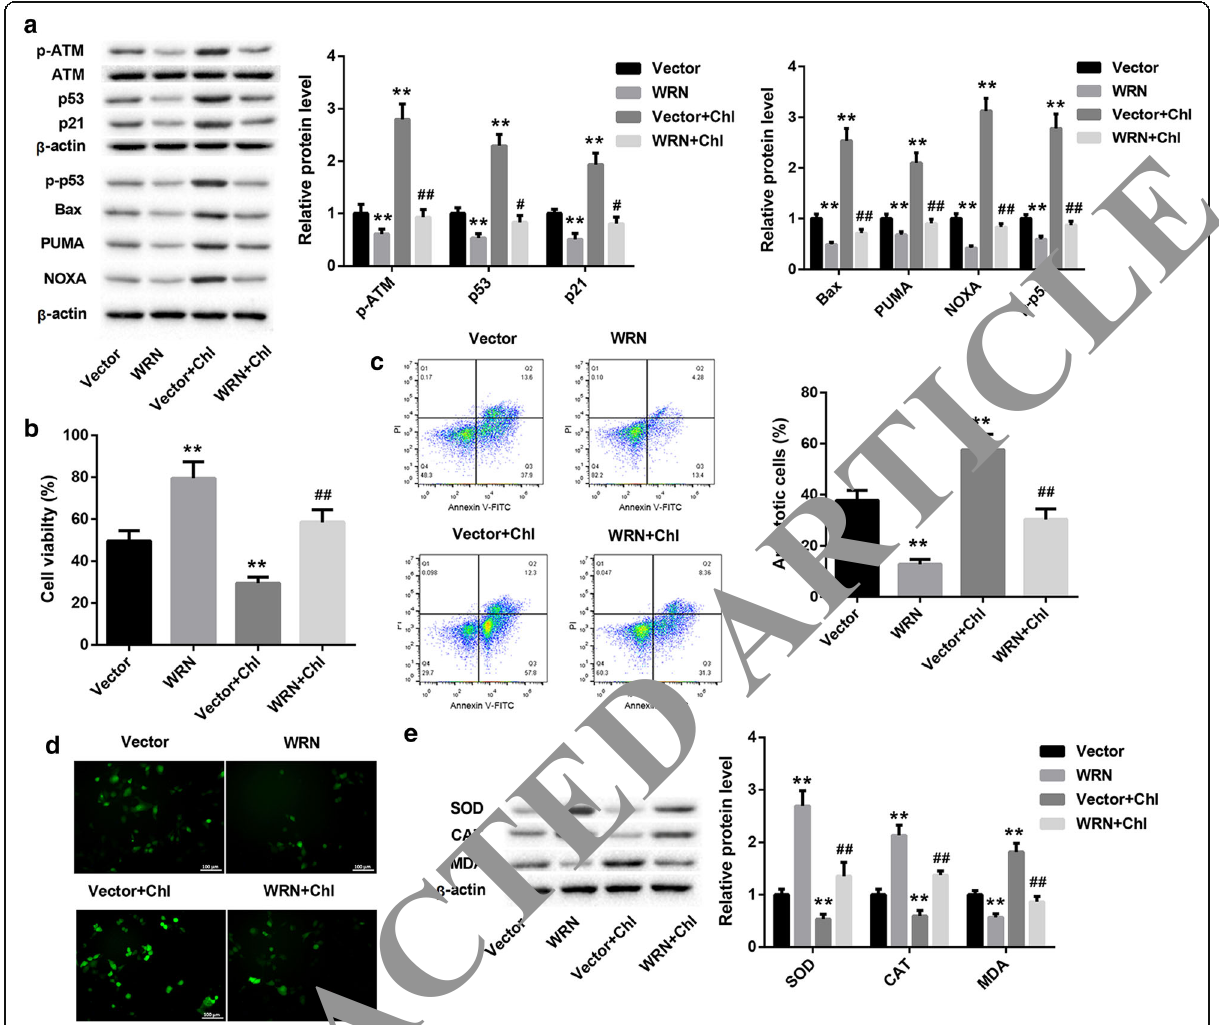
Fig. 6 WRN overexpression inhibits apoptosis and oxidative stress of SRA01/04 cells via ATM/p53 signaling pathway. SRA01/04 cells were transfected with pcDNA3.1-WRN or pcDNA3.1-NC, and then the modified SRA01/04 cells were treated with 50 μ M chloroquine. a WB was performed to detect the expression of p-ATM, ATM, p53, p-p53, p21, Bax, PUMA and NOXA in the modified SRA01/04 cells. b CCK8 was performed to explore the cell proliferation of the modified SRA01/04 cells. c The apoptosis of the modified SRA01/04 cells was determined by flow cytometry. d The content of ROS in the modified SRA01/04 cells was detected by fluorescent probe DCFH-DA. e WB was performed to explore the expression of SOD, CAT and MDA in the modified SRA01/04 cells. ( * P < 0.05 compared with the Vector group, ** P < 0.01 compared with the Vector group, # P < 0.05 compared with the Vector+Chl group, ## P < 0.01 compared with the Vector+Chl